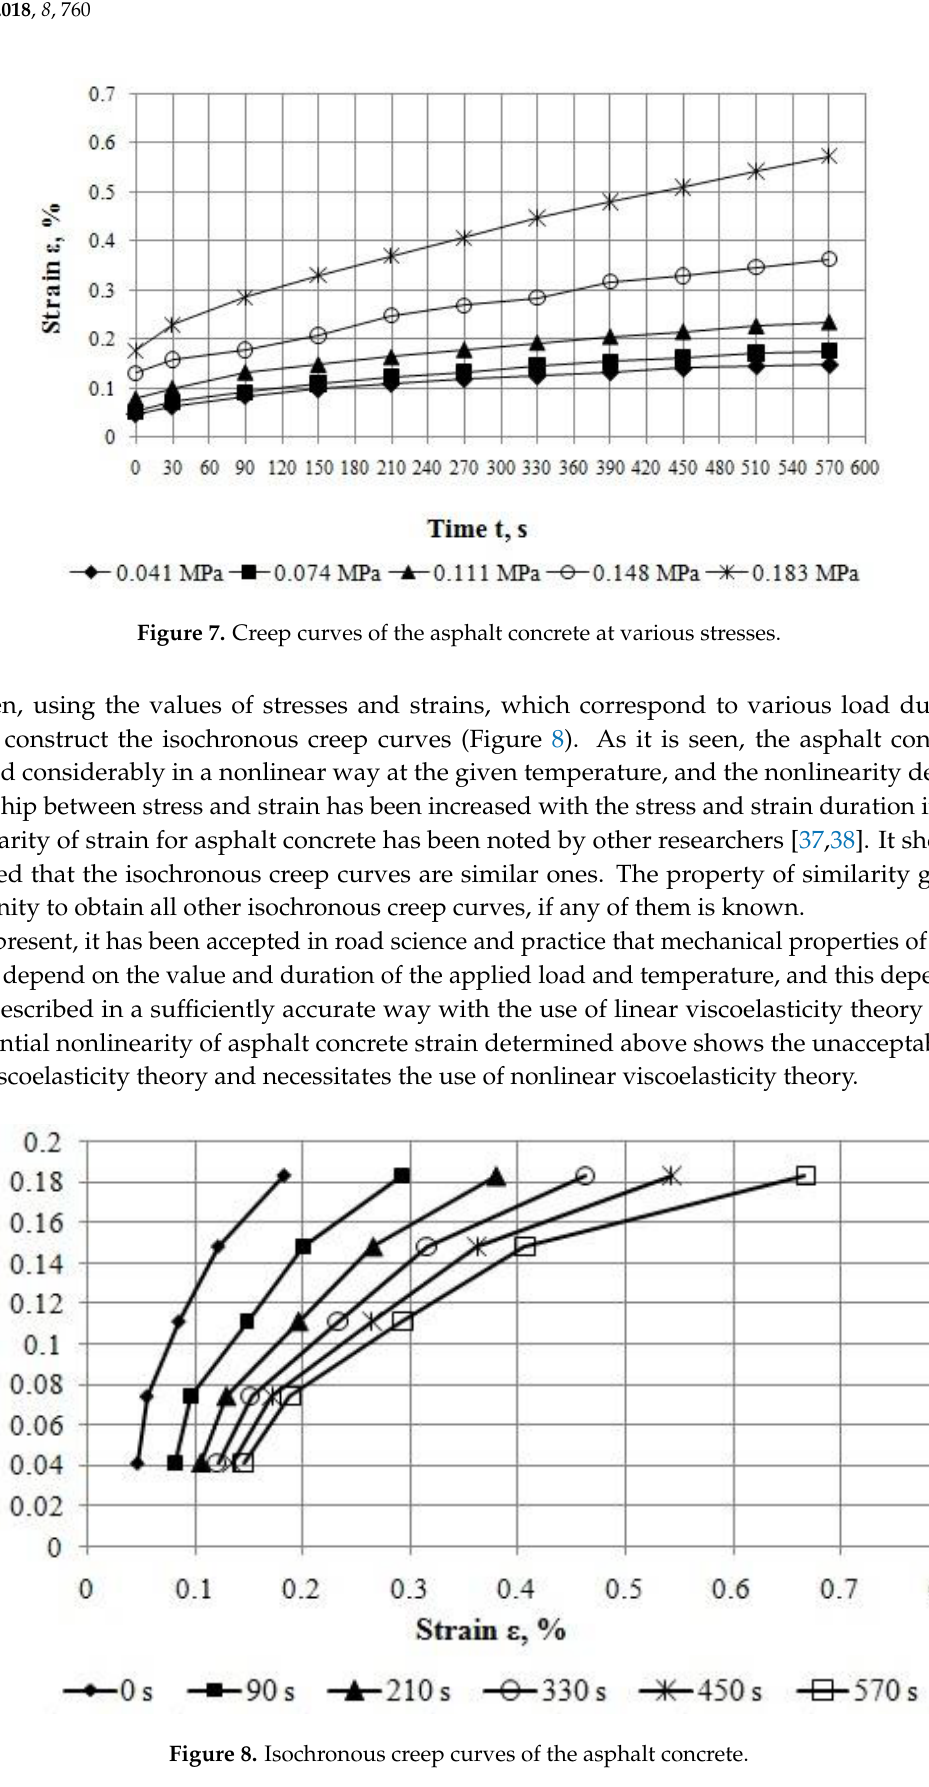
Figure 9. Graphs of experimental rheological parameter of the asphalt concrete at various stresses.